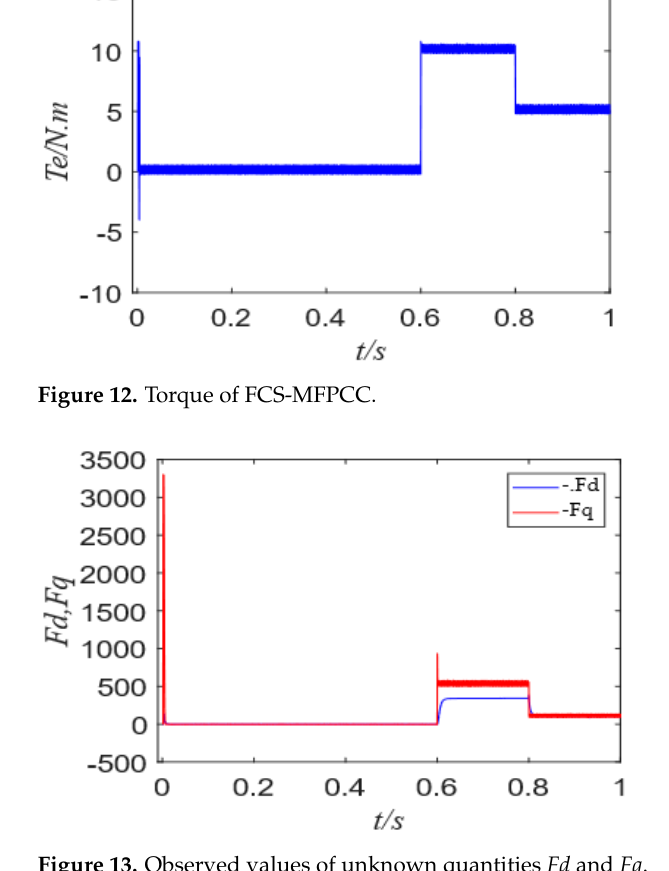
Figure 13. Observed values of unknown quantities Fd and Fq .